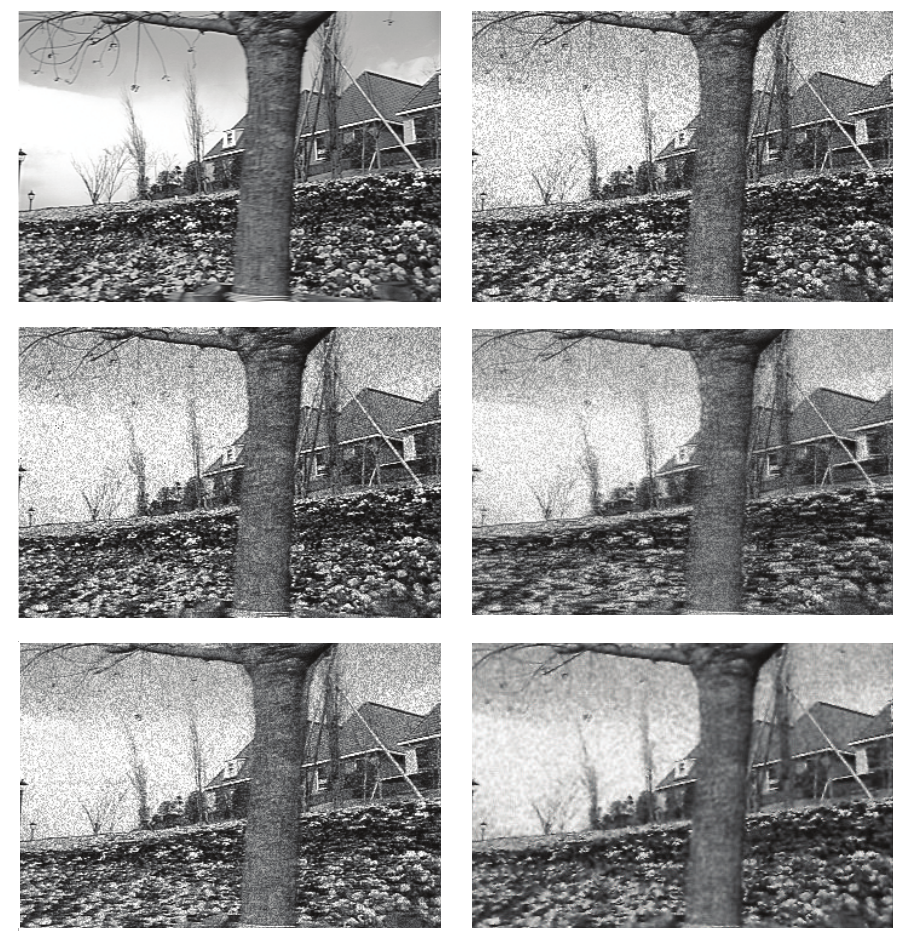
Figure 5: Visual comparison of different algorithms for frame 5 of the Flower Garden sequence. From left to right and from top to bottom: original frame, noisy frame (noise variance = 0.04 ), result of [26] algorithm, result of [27] algorithm, result of [28] algorithm, and result of the proposed